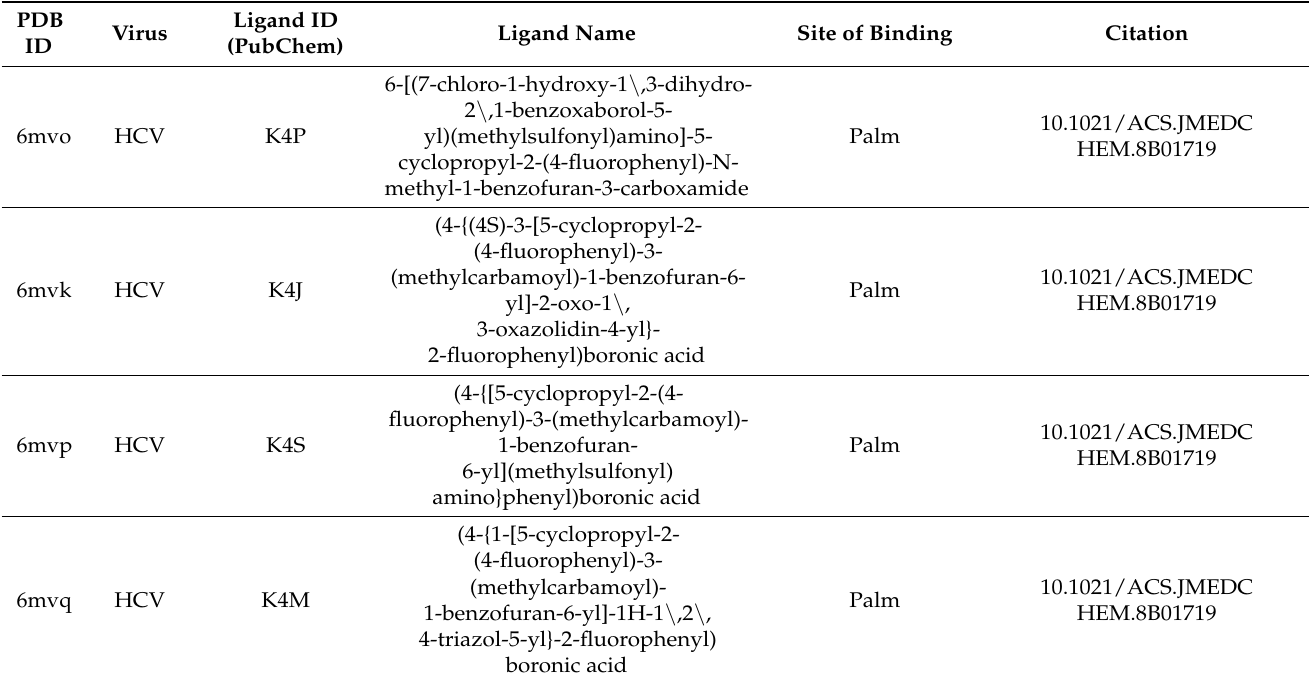
Table 2. List of recently solved crystal and cryo-EM structures of RdRPs in complex with their respective allosteric